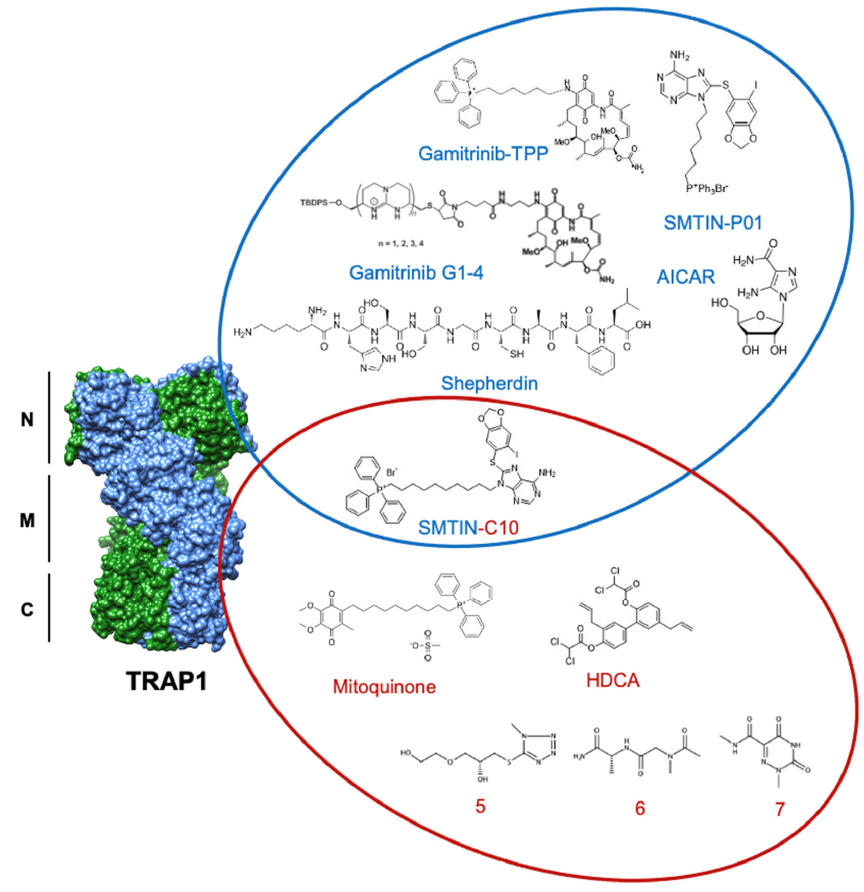
Figure 5. Structures of discussed TRAP1 inhibitors. ATP-competitive small molecules targeting the N-domain of TRAP1 (PDB: 6xg6) are labeled blue, while allosteric inhibitors, primarily targeting the TRAP1 middle domain, are labeled red. SMTIN-C10 is a bifunctional inhibitor, with elements of both ATP-competitive and allosteric inhibition. Though ATP-competitive Hsp90 inhibitors are still widely used, an alternative ap- proach in hopes of achieving TRAP1 specificity over other Hsp90 family members has emerged through allosteric targeting. One example of this strategy is honokiol bis-dichlo- roacetate (HDCA), which is able to specifically inhibit TRAP1 by binding to an allosteric pocket within the middle domain. This pocket has a surface landscape defined by a posi- tively charged region sandwiched between two negatively charged regions that are